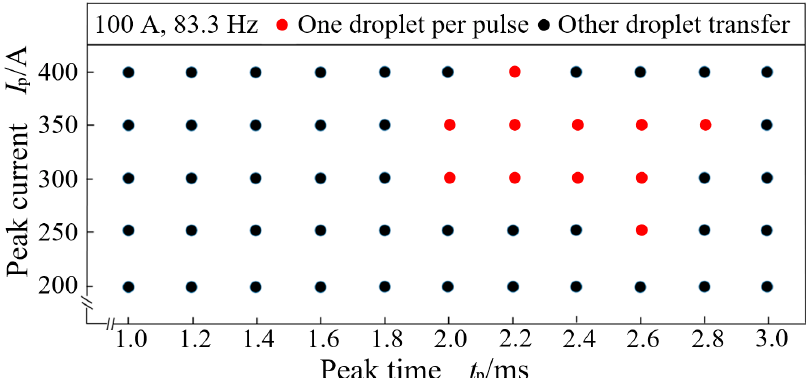
Figure 2. P-GMAW droplet transfer interval of one droplet per pulse at 100 A and 83.3 Hz.